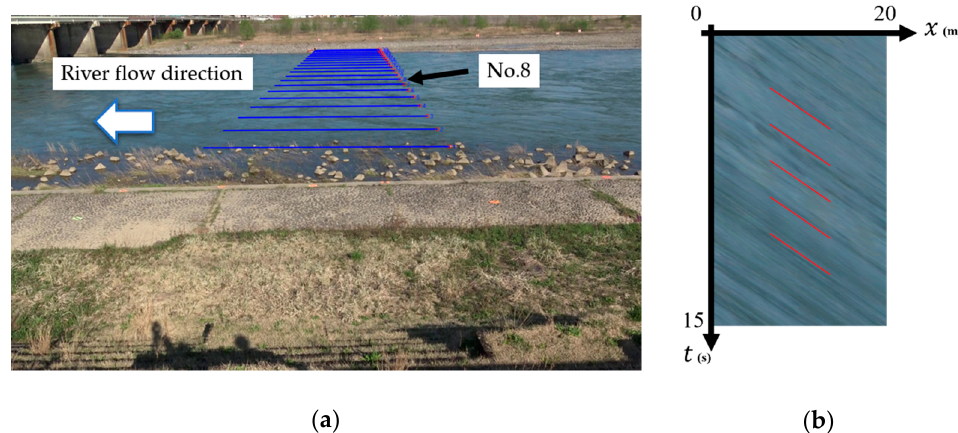
Figure 10. Normal case: The water surface is fairly flat and the flow velocity is nearly constant. The STI exhibits a linear parallel pattern without significant noises. ( a ) Obliquely viewed image; ( b ) STI, No.8 (red lines are CNN estimated angles).